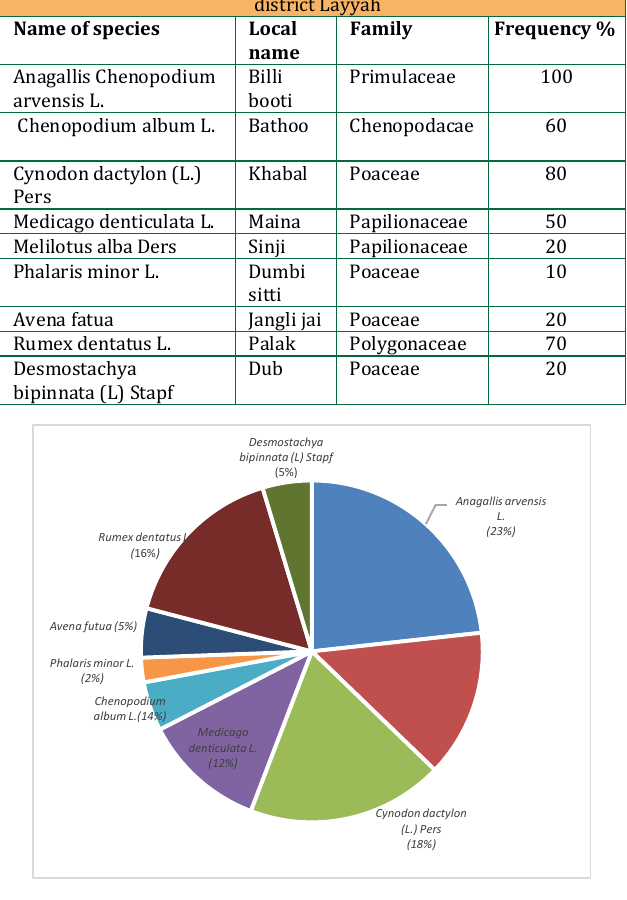
Figure 1: Frequency (%) of weed infesting in wheat field of Nawan Kot District Layyah.